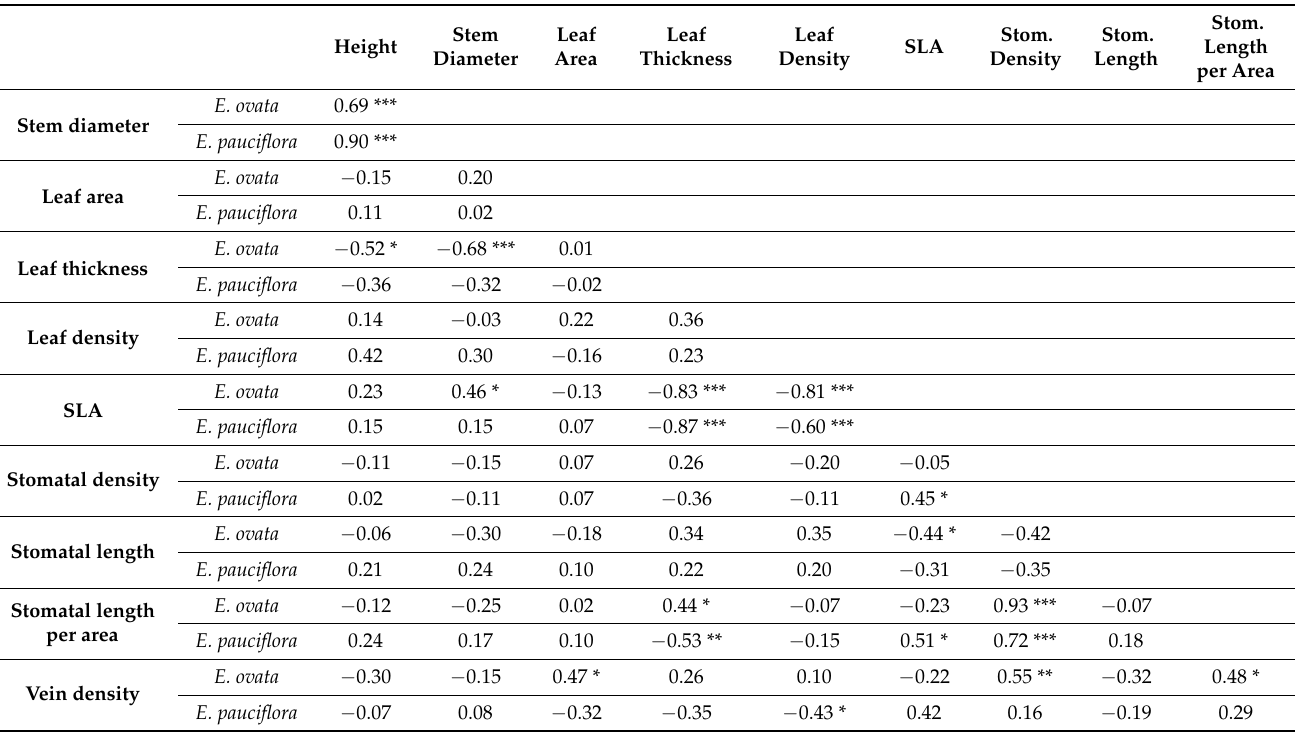
of covariation among traits within species (Table 4). Table 4. Pearson’s correlations among the trait population-means for E. ovata and E. pauciflora (22 populations per species). Stom. Stem Leaf Leaf Leaf Stom. Stom. Height SLA Diameter Area Thickness Density Density Length